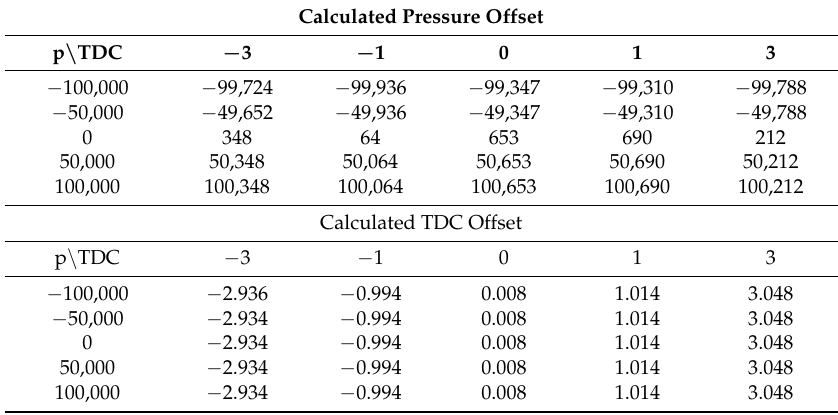
Table B1. Calculated pressure and TDC offsets and their absolute errors for the PSA engine and operating point 2000 1/min and 20 Nm using the off-line